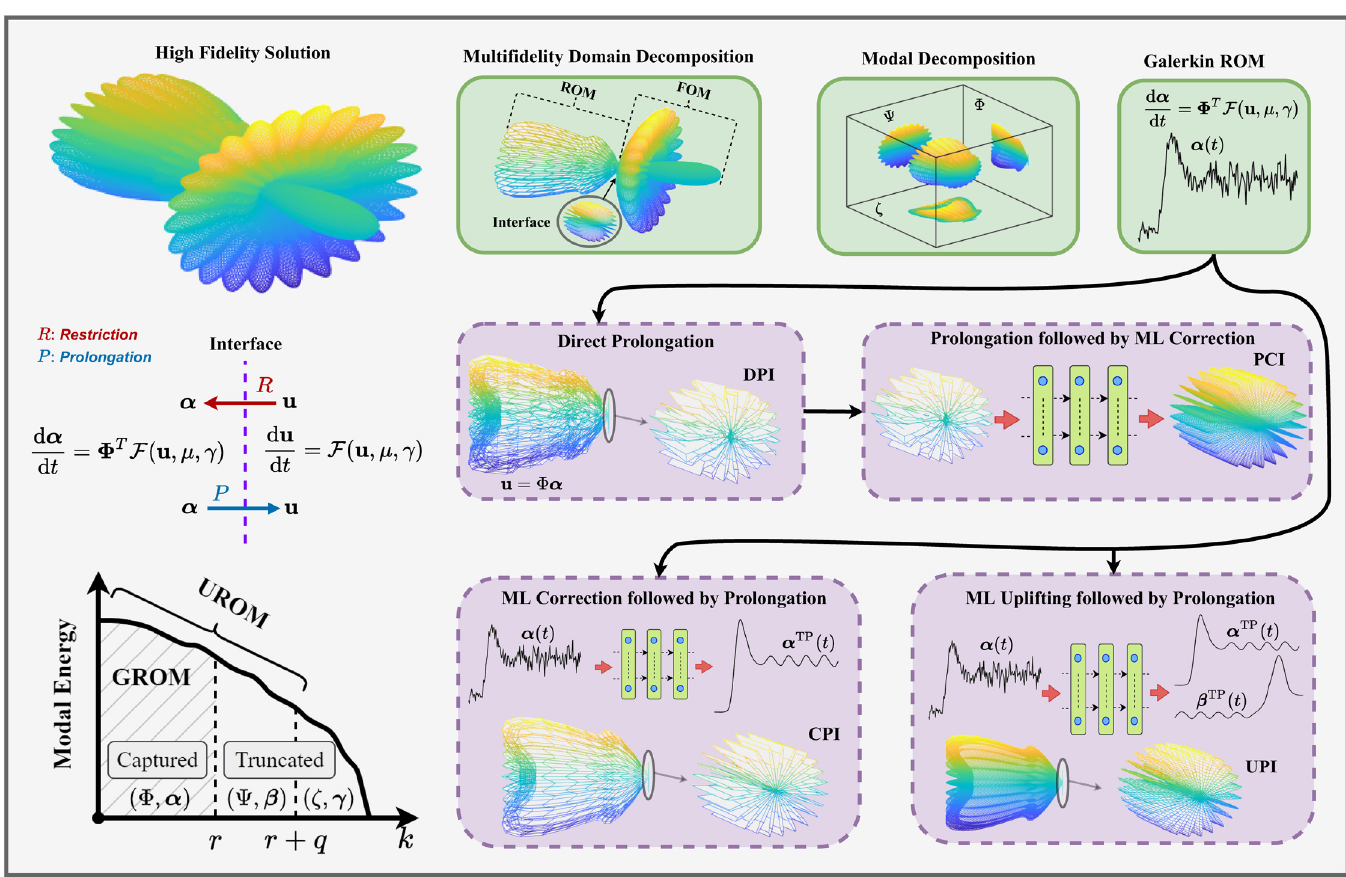
Fig 2. Schematic illustration of the methodologies introduced to utilize ROM to economically provide sound interface conditions in a multifidelity domain decomposition problems. Galerkin ROM yields inaccurate predictions (represented by rough curve), and direct prolongation of these results might be not efficient. PCI adds a correction effect to the prolonged solution in FOM space. Instead, CPI and UPI introduce the correction at ROM level before prolongation. UPI adds an extra superresolution effect to augment solution quality.